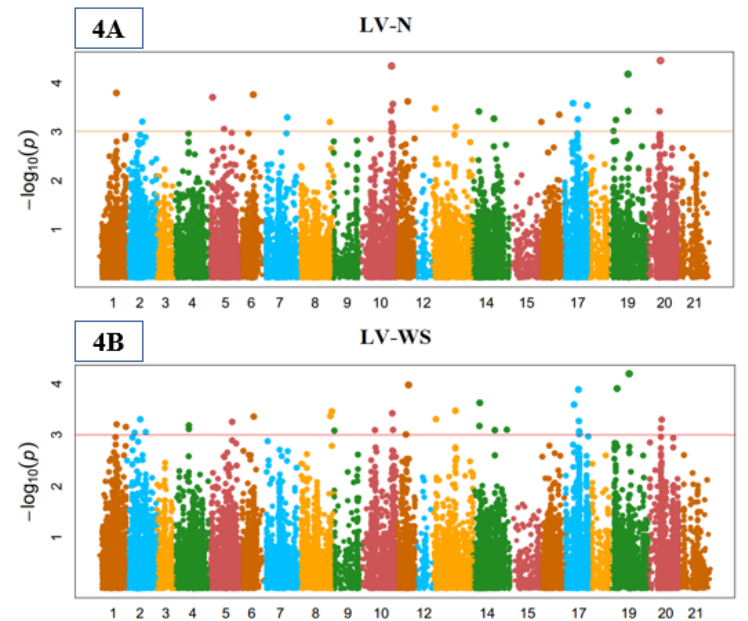
Figure 4. Manhattan plot of leaf venation (LV) under normal (N) ( A ) and water shortage (WS) ( B ) conditions. Manhattan plots showing the location of significant SNPs and − log10( p ) associated with leaf venation in bread wheat under normal and water shortage conditions. The red horizontal line on Manhattan plot entitles the threshold level ( p < 0.0001) of significance for SNPs with this trait.